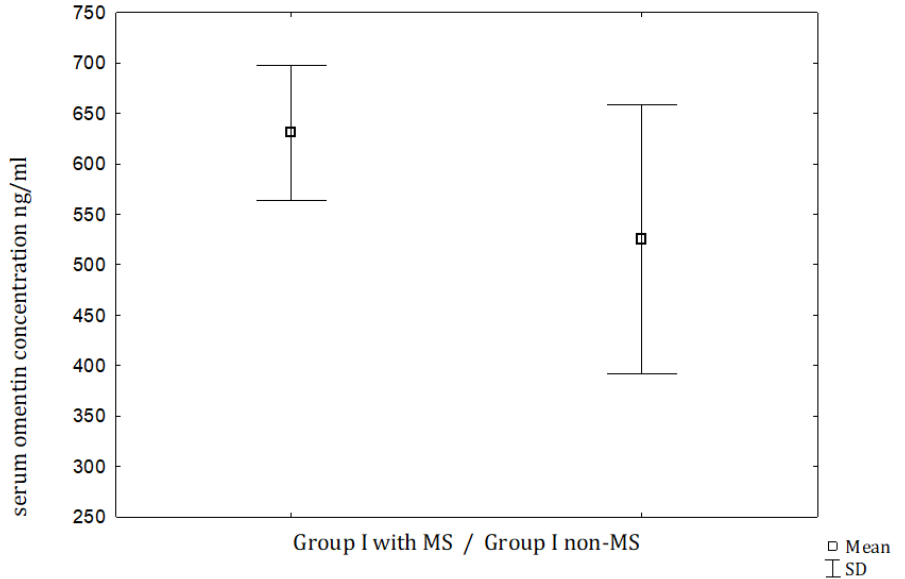
Figure 2. Comparison of serum omentin between men with PC and metabolic syndrome versus men with PC without metabolic syndrome. p = NS, not statistically significant.